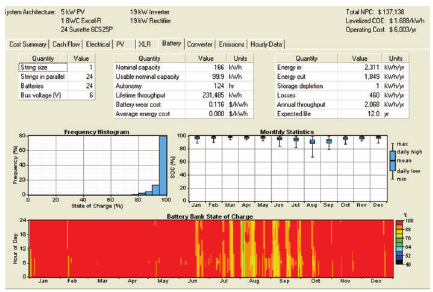
Figure 14: Battery bank state of charge